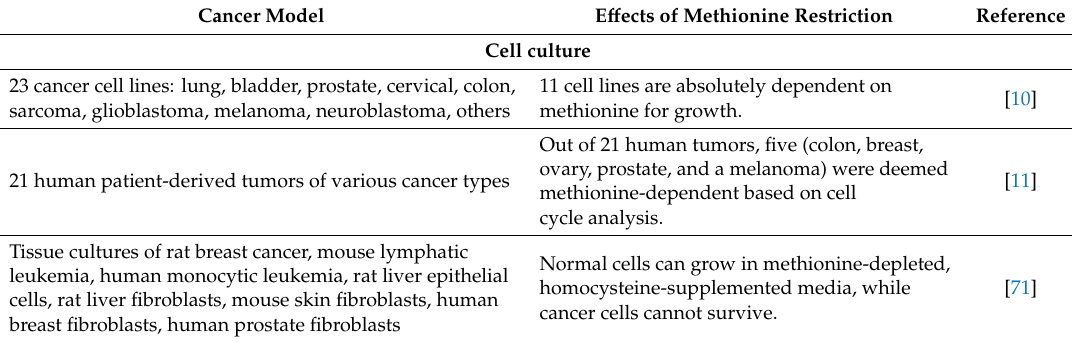
Table 1. Methionine restriction and cancer